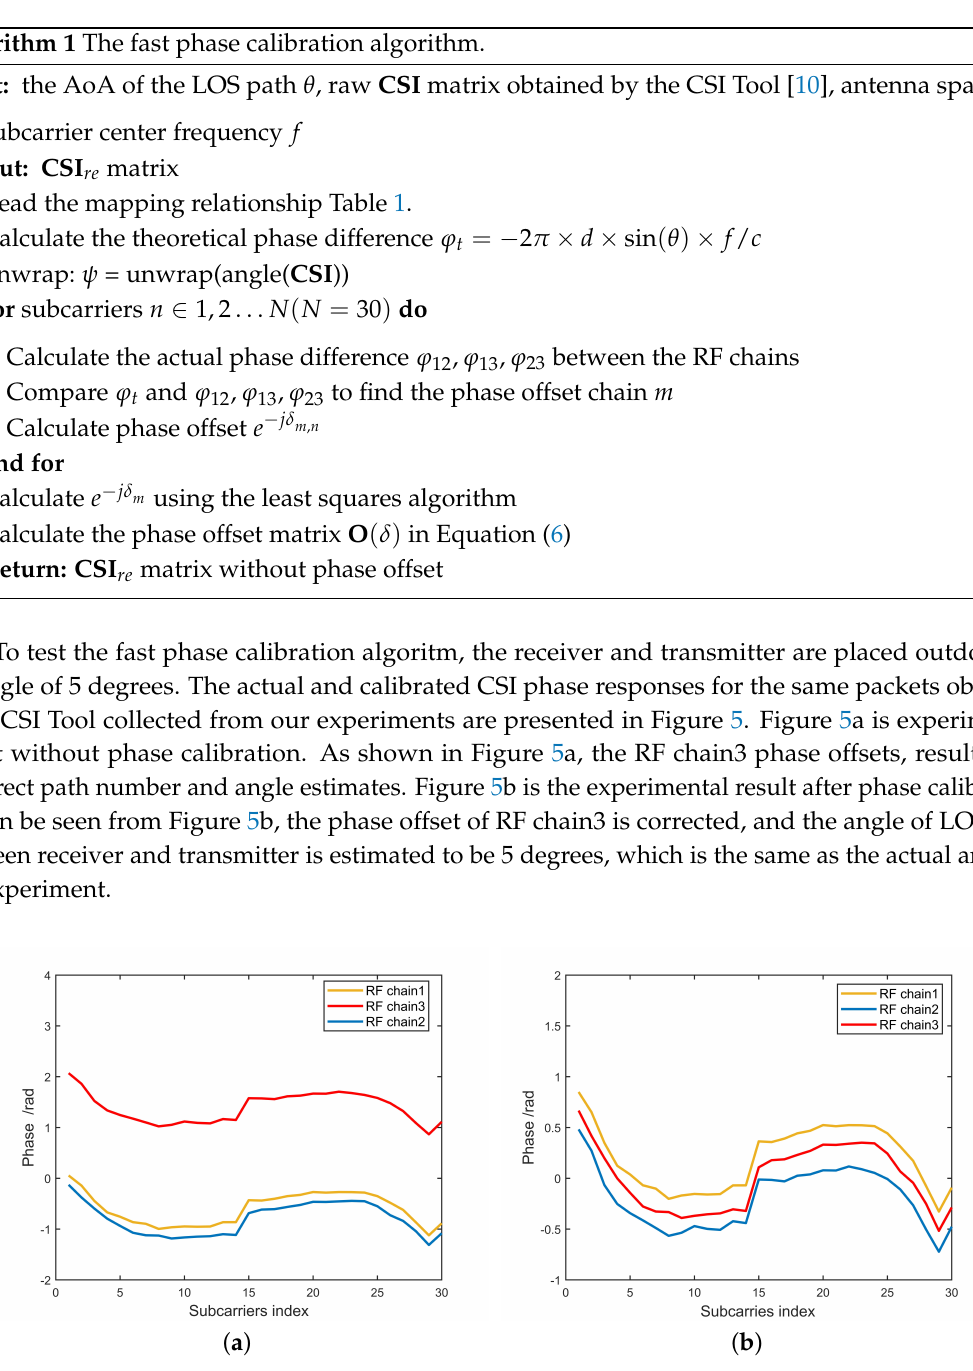
Figure 5. Unwrapped CSI phase. ( a ) Unwrapped CSI phase with phase sanitization, without phase calibration. ( b ) Unwrapped CSI phase with phase sanitization and phase